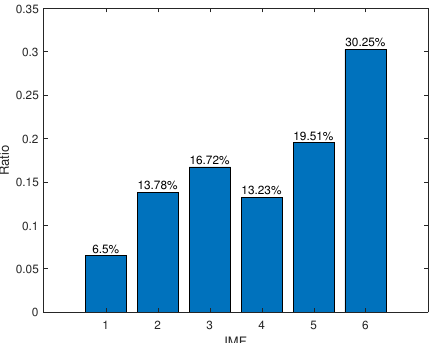
Figure 11. The energy ratio distribution of subseries for IF data by VMD